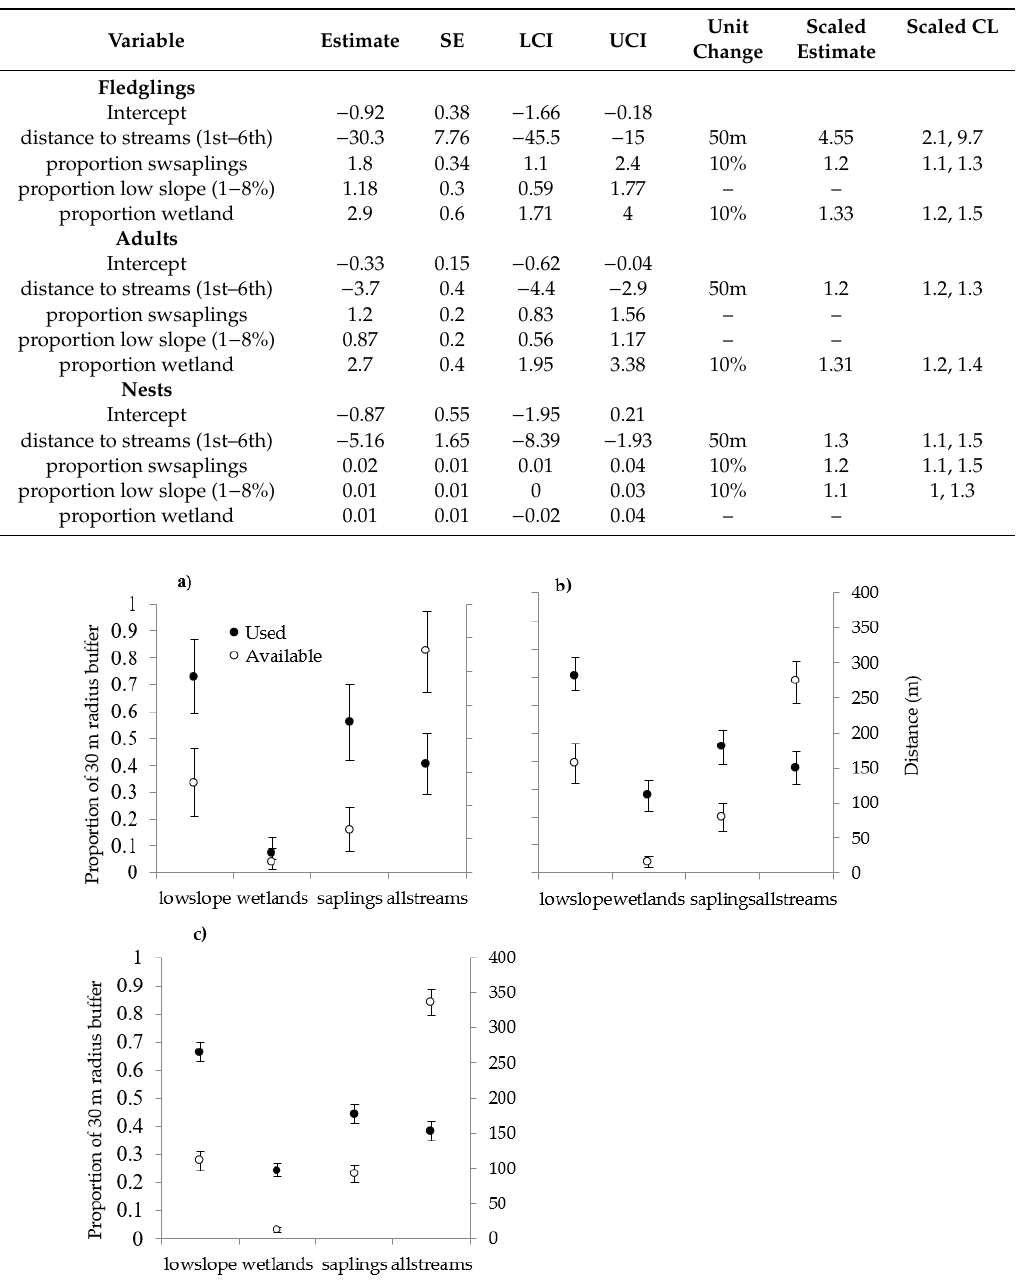
Table 3. Adjusted, scaled back-transformed log-odds estimates for rusty blackbird fledglings (n = 10), adults (n = 29), and nests (n = 37) in New Hampshire from 2010–2012 including estimates, SE, and 95% upper and lower confidence intervals. Scaled log odds estimate reads: it is 1.3 times more likely a rusty blackbird will be present with every 10% increase in the proportion of sapling stands in a 30 m radius bu ff er. Confidence limits including 1 indicate no e ff ect and are denoted “–”.